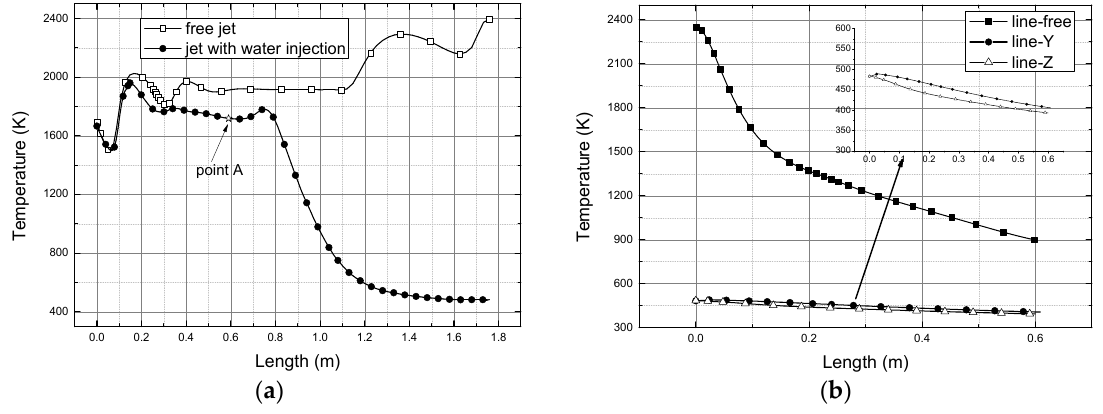
Figure 13. ( a ) Axial temperature; ( b ) Temperature of the testing bench.